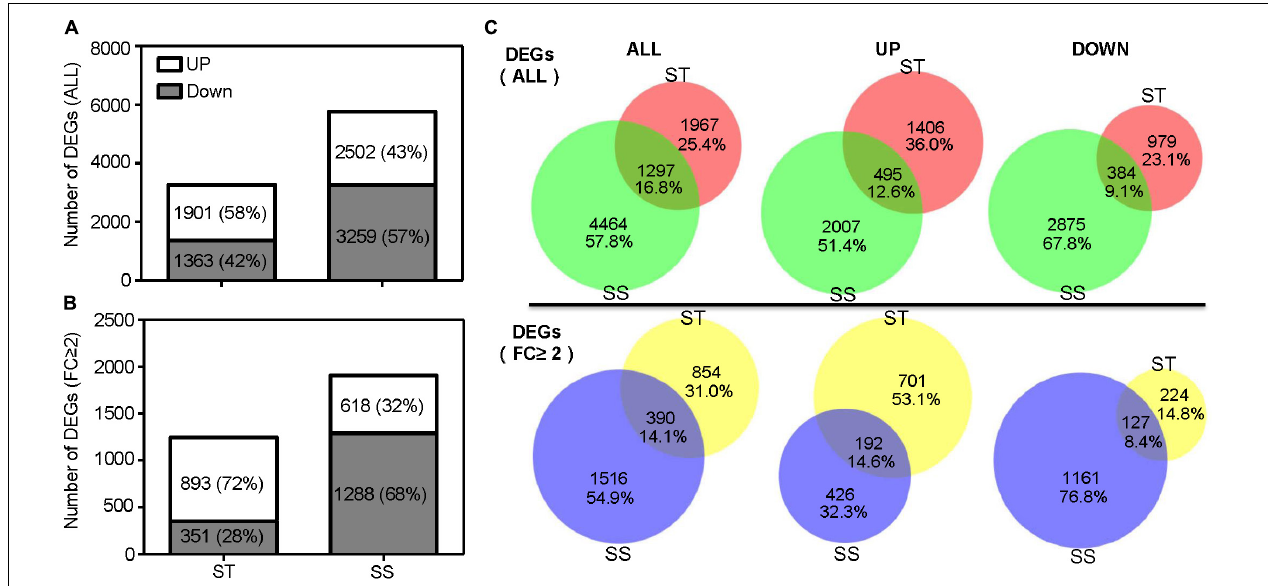
FIGURE 2 | Number of differentially expressed genes (DEGs). (A) Histograms show total DEGs and (B) DEGs with a 2-fold or greater change in expression. (C) Venn diagram illustrates the number of overlapping DEGs between salt-tolerant (ST) and salt-sensitive (SS).